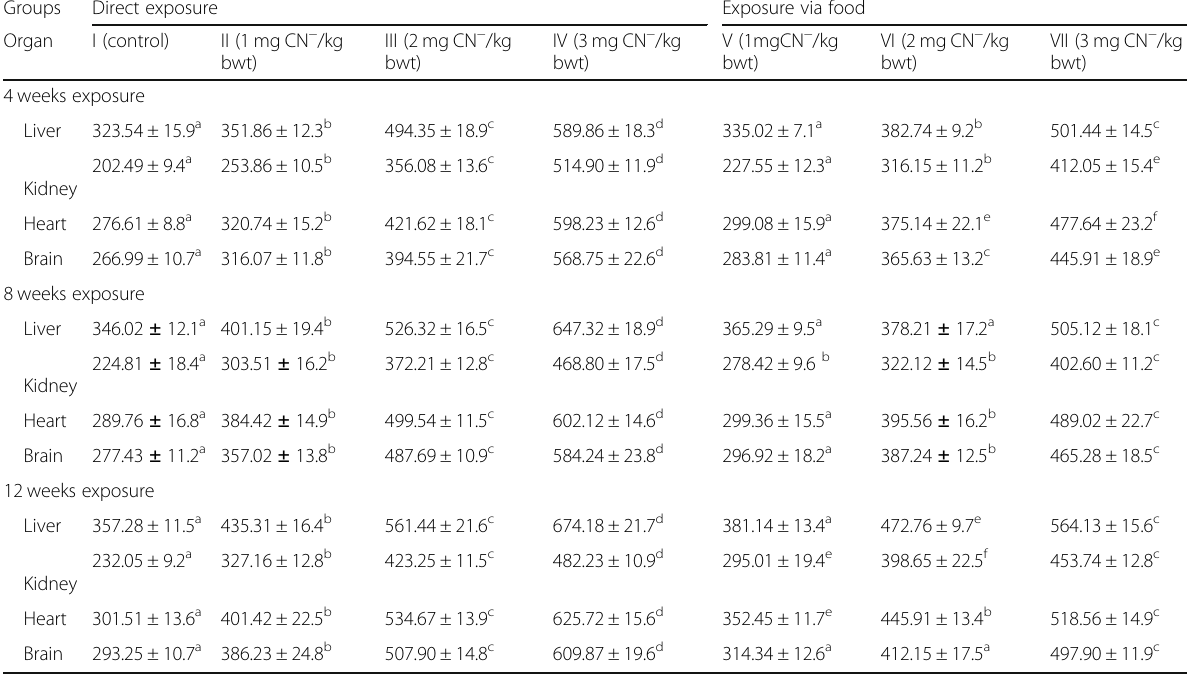
Table 2 The level of lipid peroxidation (LPO) in some organs of birds exposed to cyanide directly and indirectly in feed